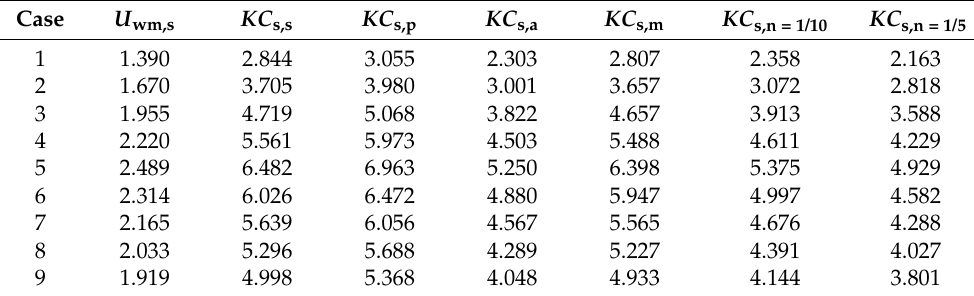
Table 4. U wm,s and KC for case 1~9.